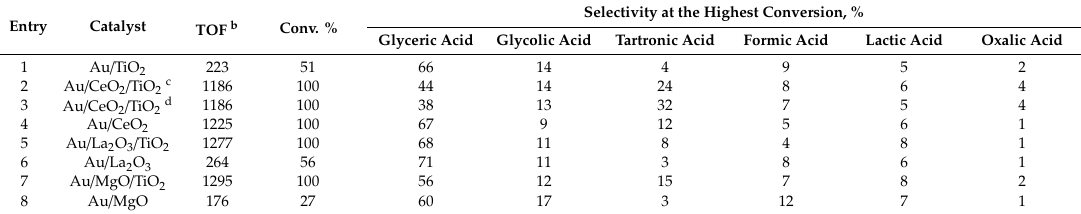
Table 2. Catalytic performance of gold-supported catalysts a